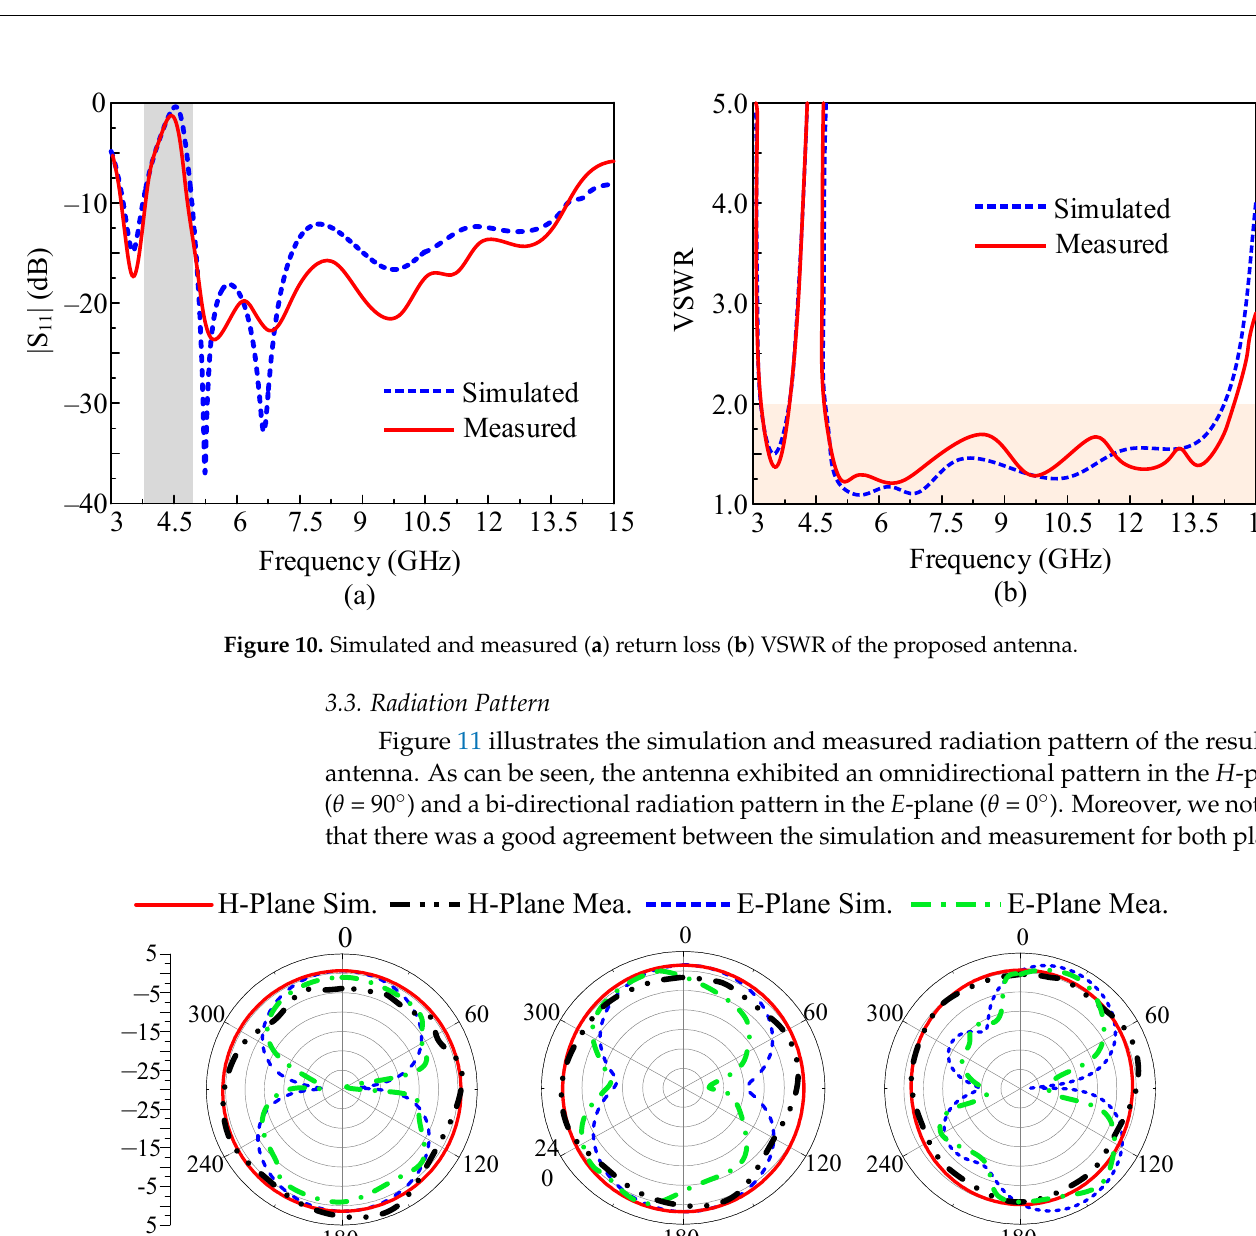
Figure 11. Radiation patterns of the antenna: ( a ) 3.5 GHz, ( b ) 5.8 GHz and ( c ) 8 GHz.